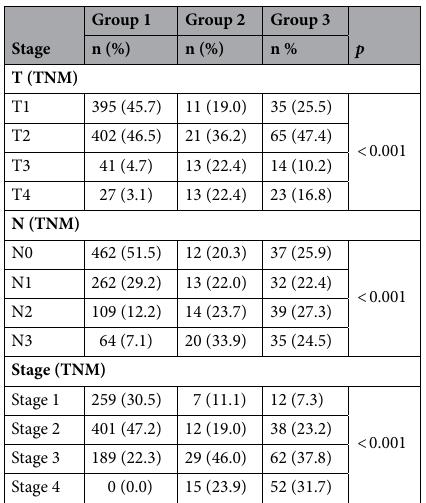
Table 5. Comparison of cancer stages according to TNM classificatıon.